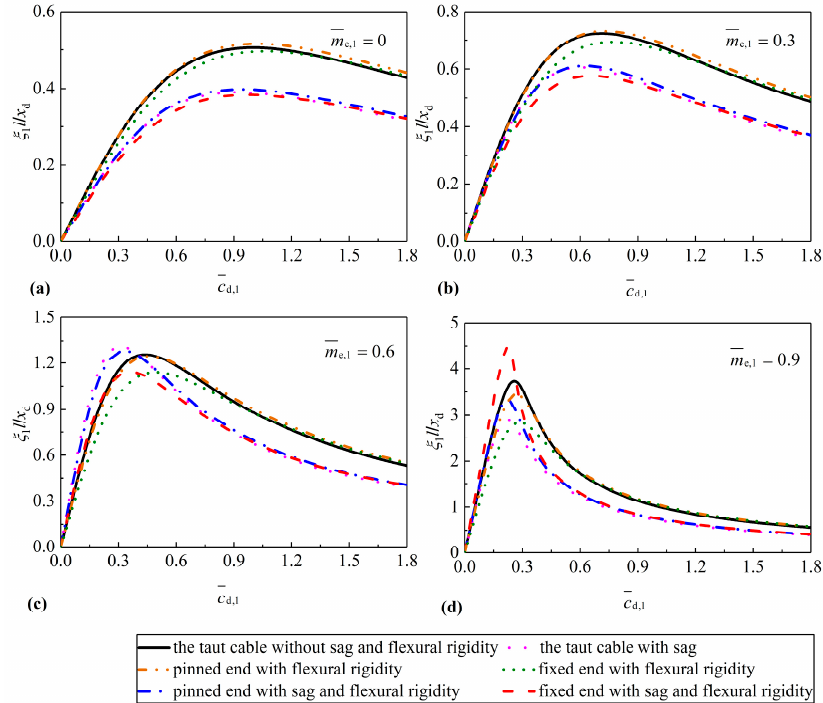
Figure 12. The first supplemental modal damping ratio of the long cable versus damping coefficient for various inertial masses: ( a ) m e,1 = 0; ( b ) m e,1 = 0.3; ( c ) m e,1 = 0.6; ( d ) m e,1 =